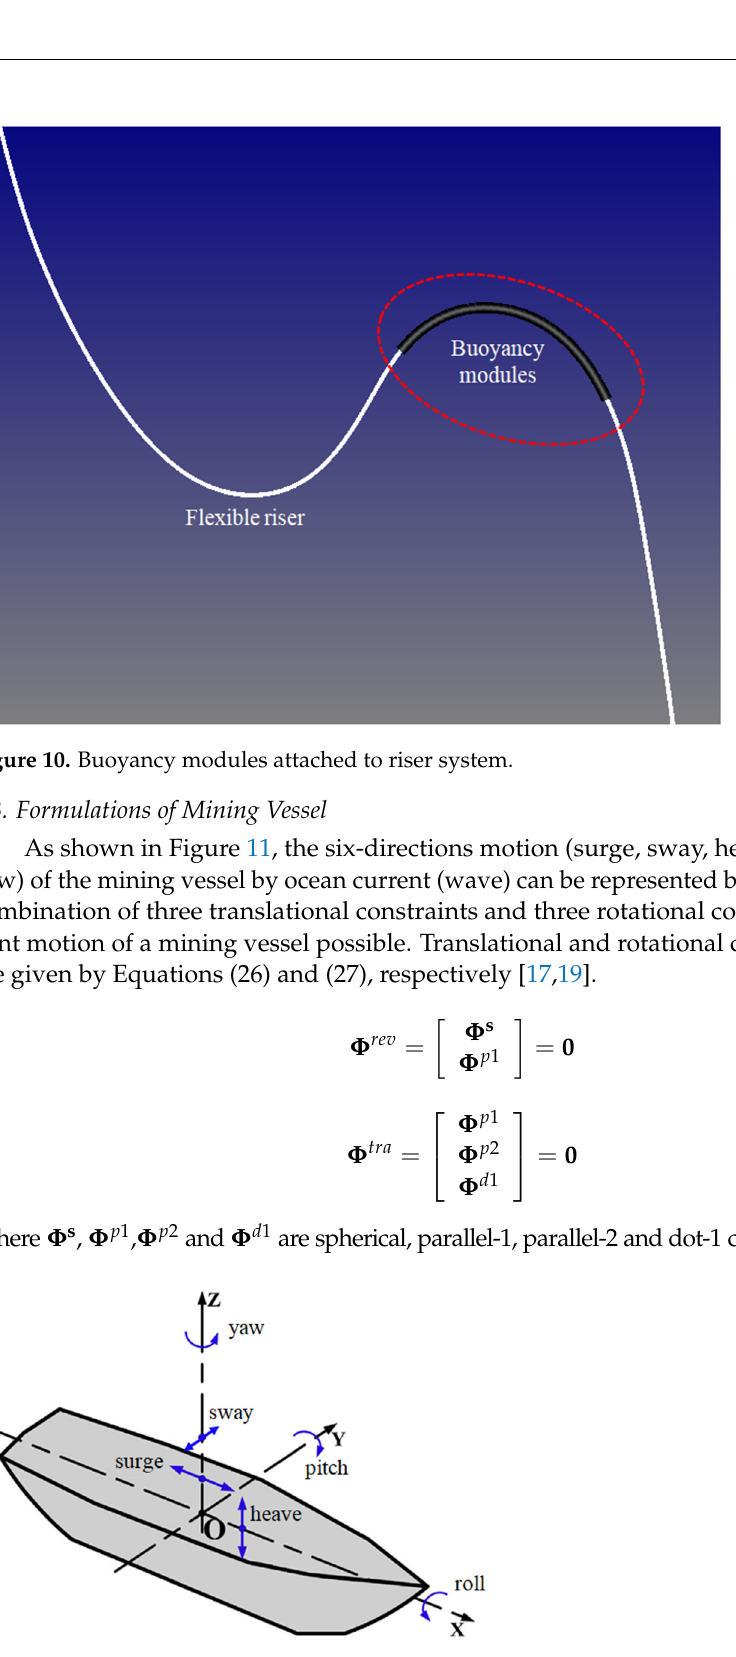
Figure 9. Kinematic relationships of hydrodynamics and buoyancy in buoyancy modules.